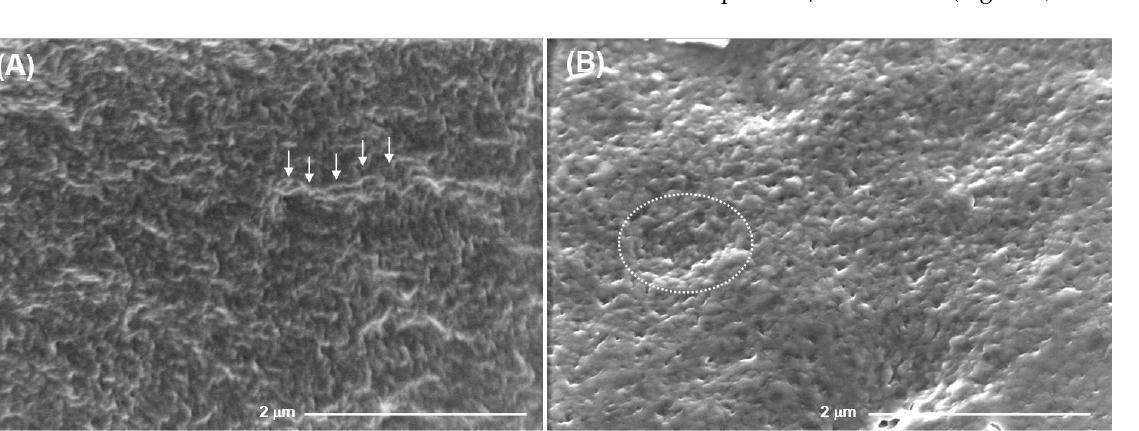
Figure 3. Scanning electron micrographs of the surfaces of the FeP ( A ) and CaP ( B ) hydrogels at 84 and 124 mM of Fe 3+ and Ca 2+ , respectively. Magnification: 25,000 × , scale bar: 2.0 µ m. Arrows and a dotted circle indicate a representative fiber-like formation and pit,